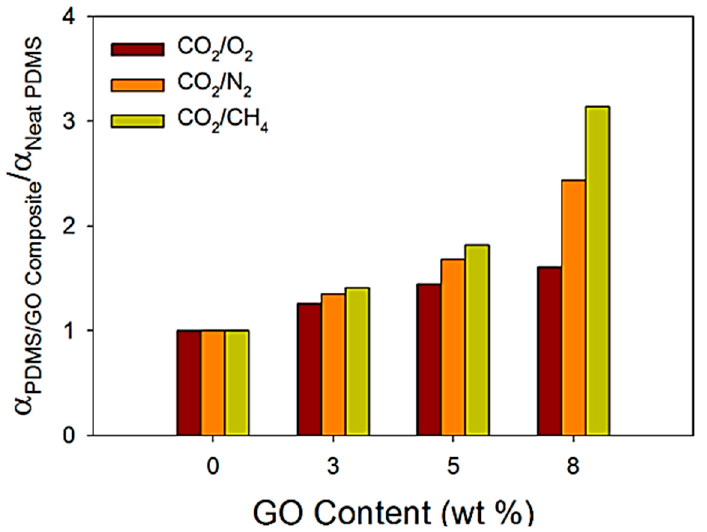
Figure 10. Relative ideal selectivity of CO 2 for poly(dimethyl siloxane)/graphene oxide nanocomposite [116]. Reproduced with permission from Elsevier.